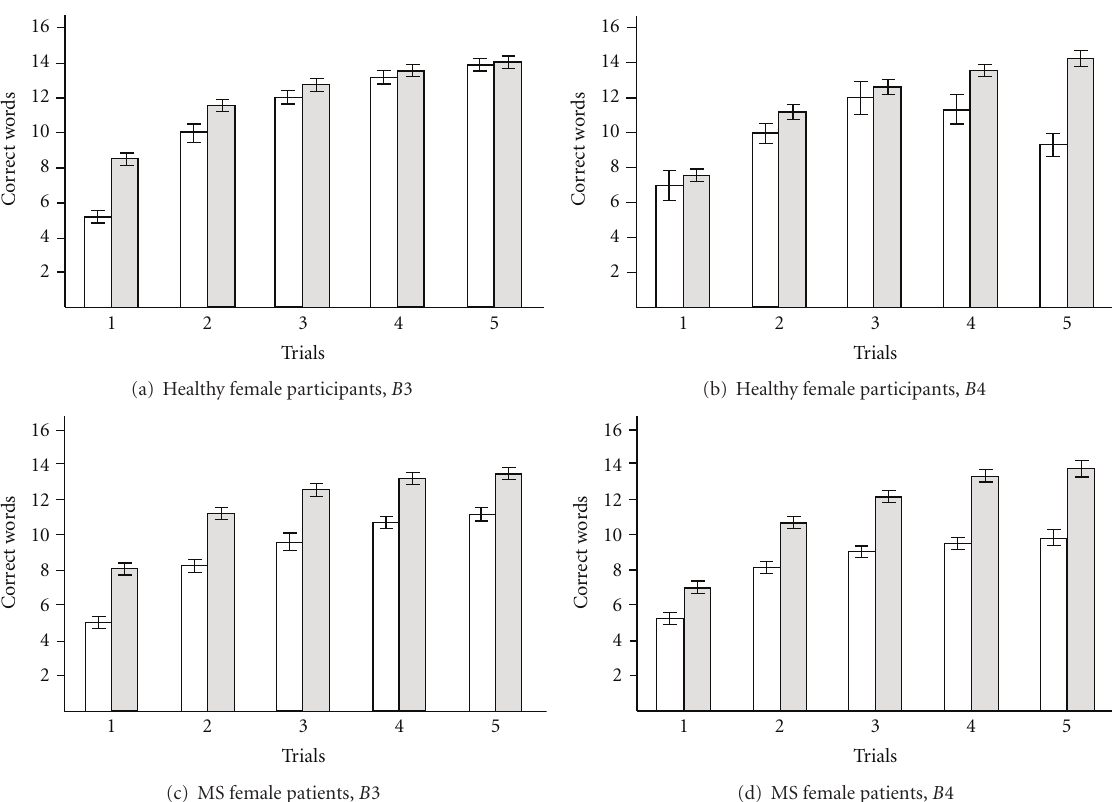
Figure 6: Cluster analysis using B 3 or B 4 in females. (a) Healthy female participants: clustering using B 3 only, cluster referring to lower memory functioning (22 cases) and cluster referring to higher memory functioning (56 cases). There is no overlap between these B 3 clusters. (b) Healthy female participants: clustering using B 4 only, cluster referring to lower memory functioning (3 cases) and cluster referring to higher memory functioning (75 cases). There is no overlap between these B 4 clusters. (c) MS female patients: clustering using B 3 only, cluster referring to lower memory functioning (152 cases) and cluster referring to higher memory functioning (114 cases). There is no overlap between these B 3 clusters. (d) MS female patients: clustering using B 4 only, cluster referring to lower memory functioning (109 cases) and cluster referring to higher memory functioning (157 cases). There is no overlap between these B 4 clusters. Cluster referring to lower memory functioning—white bars, cluster referring to higher memory functioning—gray bars. Each bar represents mean ±